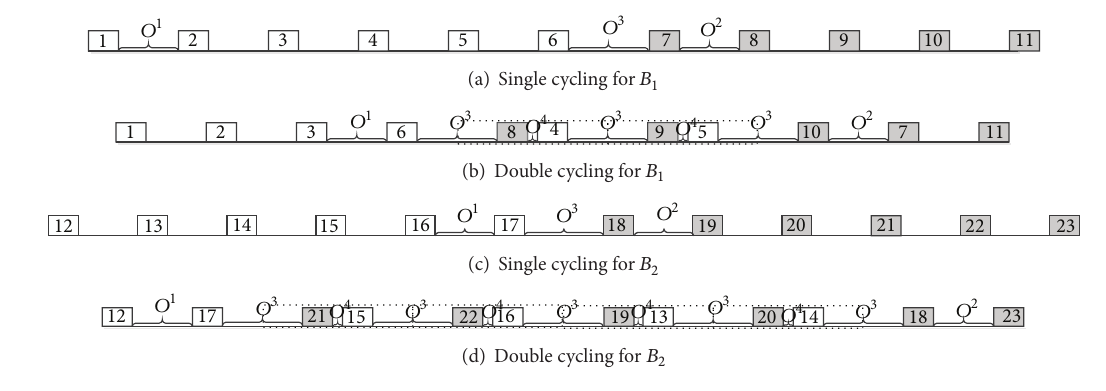
Figure 6: Time Gantt chart (a)–(d).